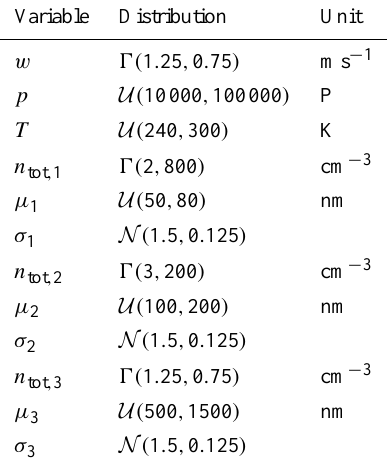
Table 3. The prior probability distribution models used for the cloud droplet formation parameterization inputs. The U , N , and 0 denote the uniform, Gaussian and gamma distributions, respectively. The details of the probability distribution functions are shown in Table 4.